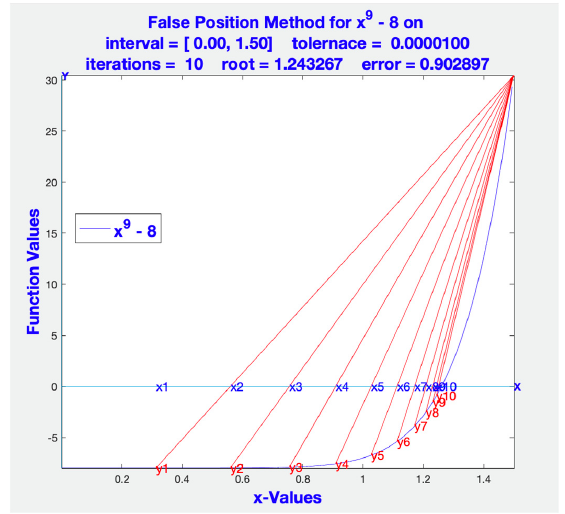
Figure 3. Convex function concave down, right endpoint fixed.